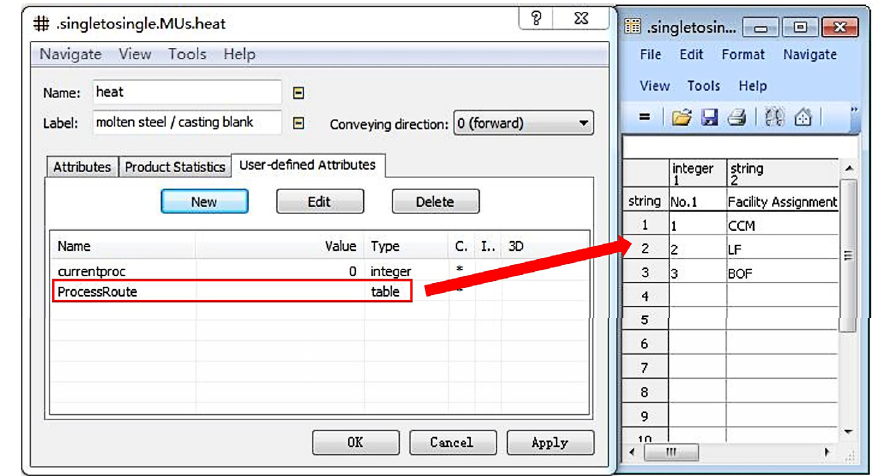
Figure 5. Collection of facility assignments of heats in each process.